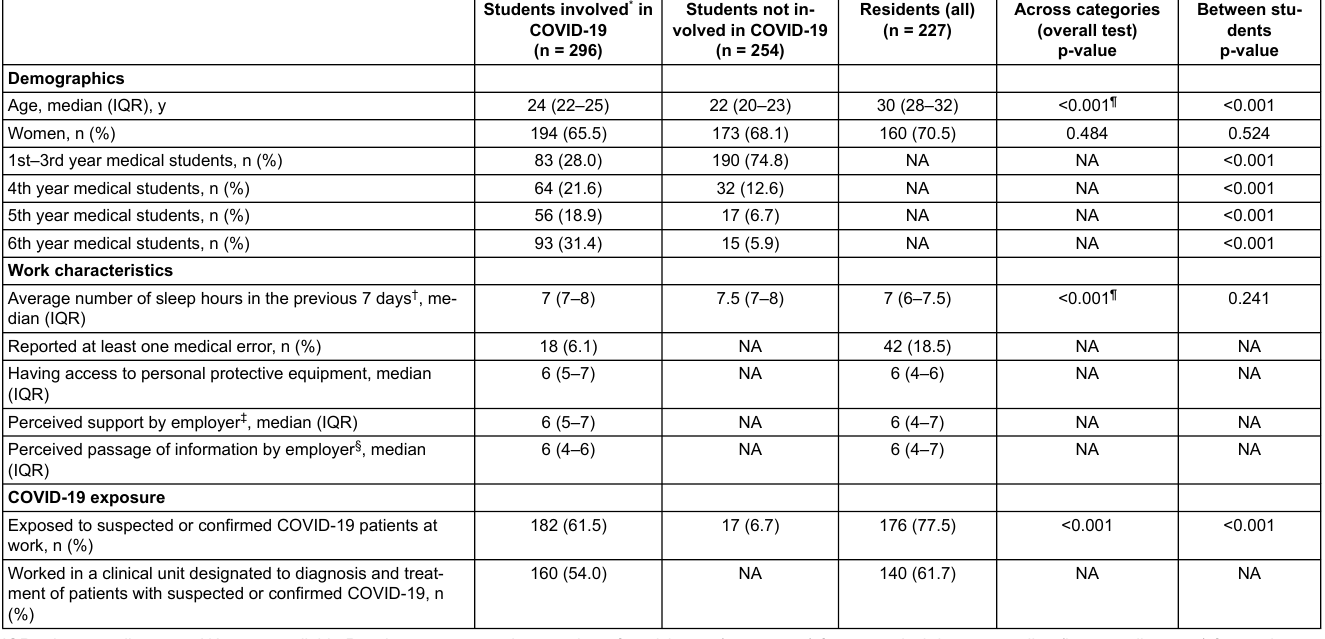
Table 1: Demographics, work characteristics, and COVID-19 exposure of medical and residents (n = 777).